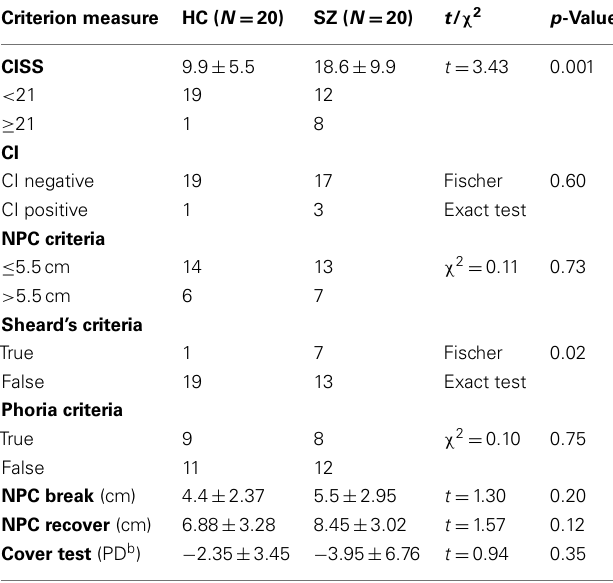
Table 2 | Convergence insufficiency symptom survey scores and CI clinical measures, between group comparisons a